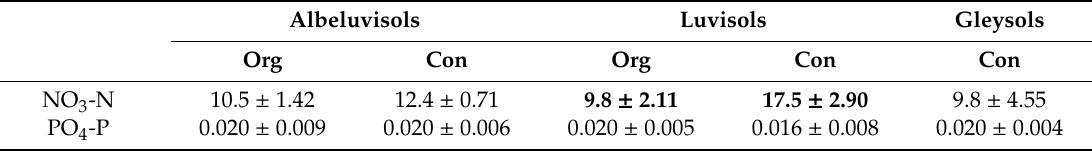
Table 2. Mean measured concentration of NO 3 -N and PO 4 -P in drainage runoff in mg L − 1 per year from 1995 to 1997 in different soils and cropping intensity, V ė žai č iai site (statistically significant differences between the means are bolded).